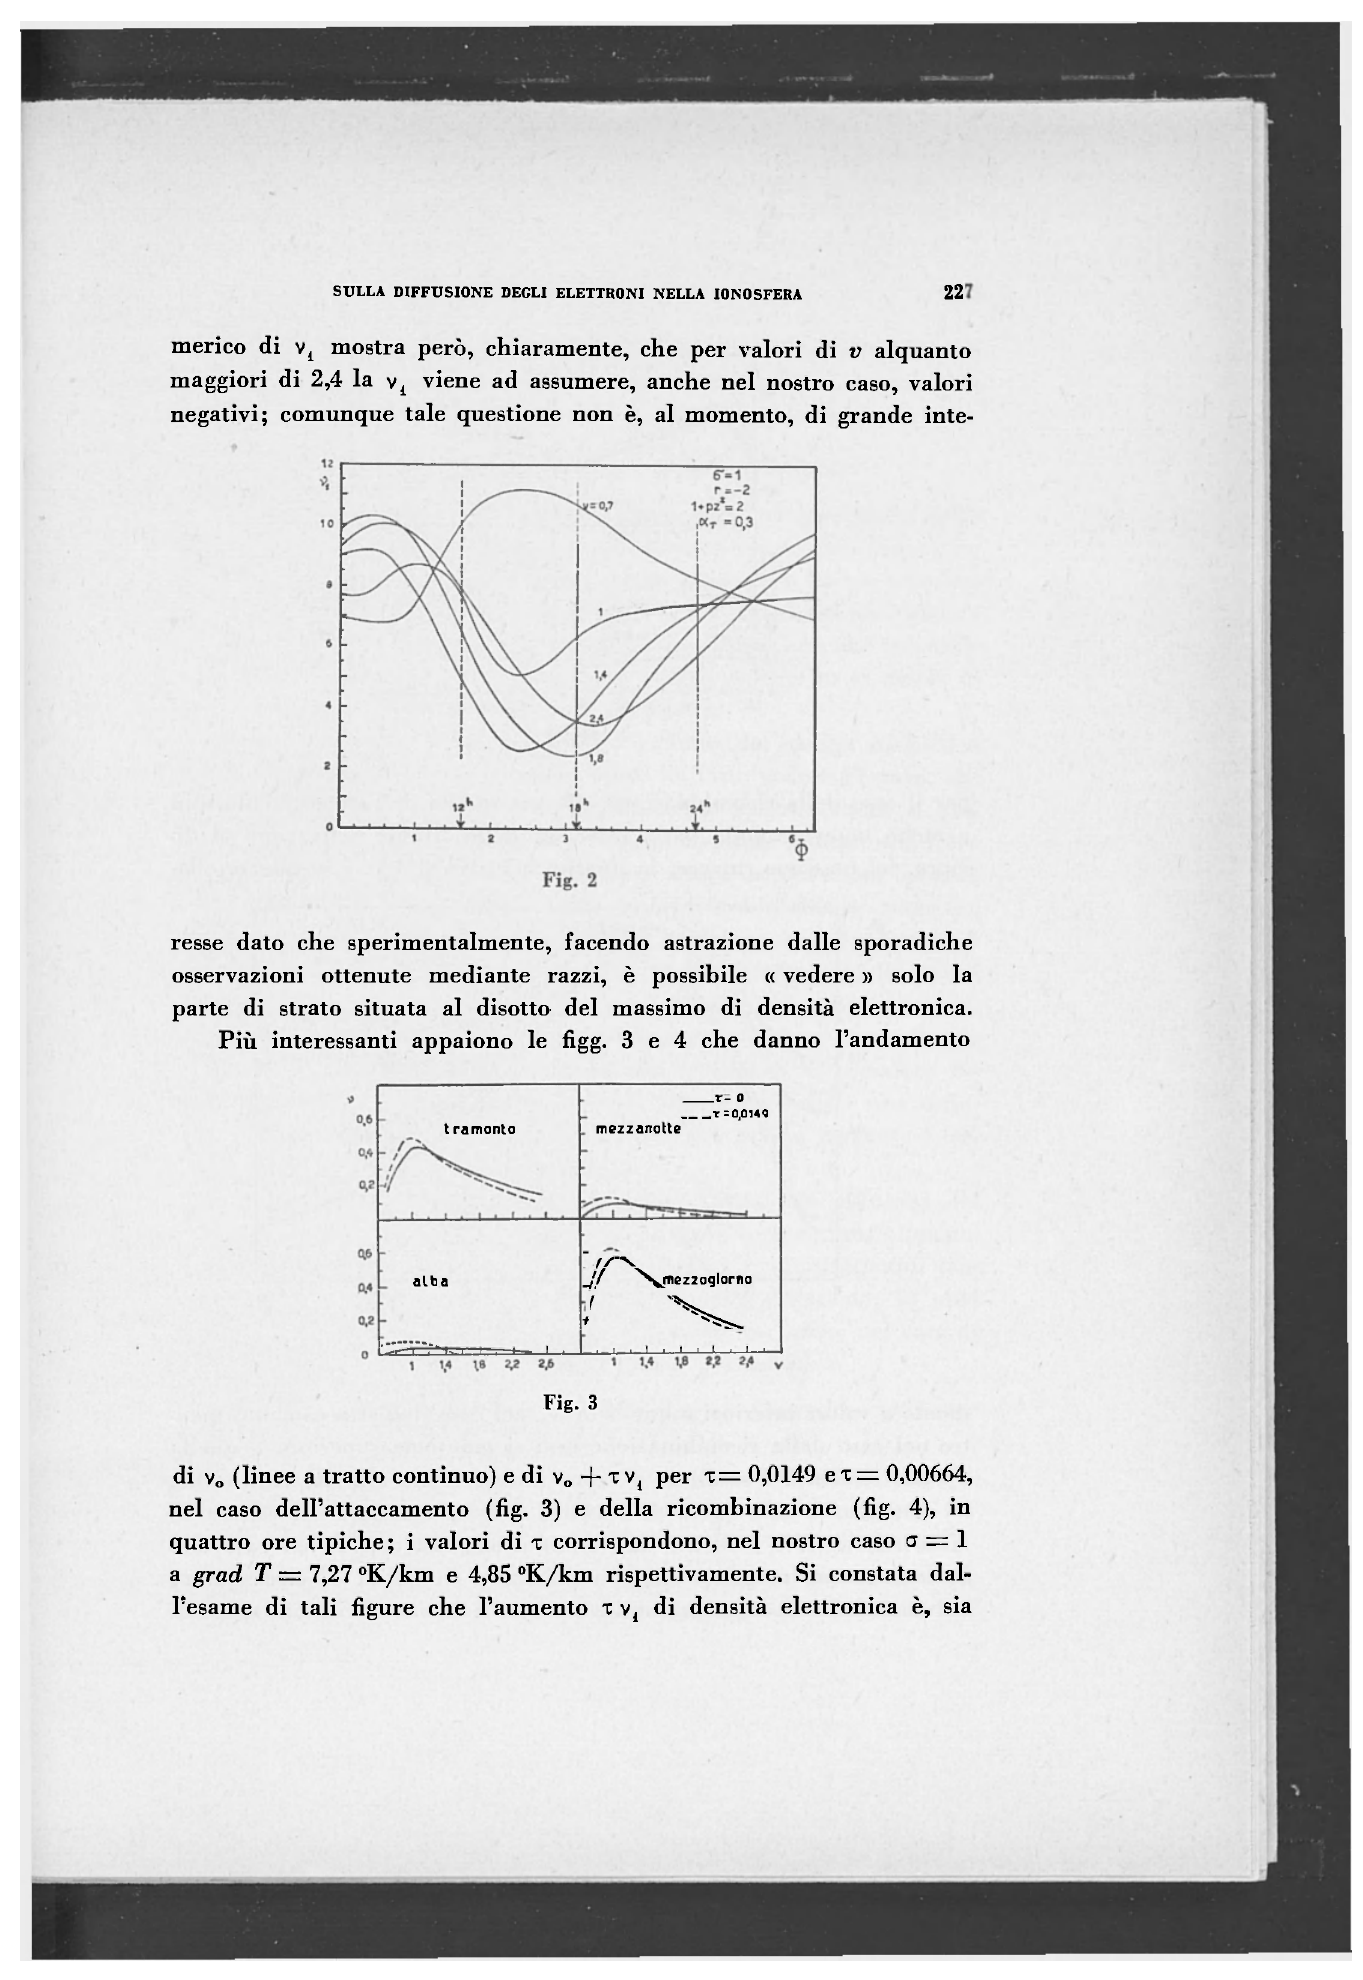
di v„ (linee a tratto continuo) e di v„ + x v { per x= 0,0149 e x =